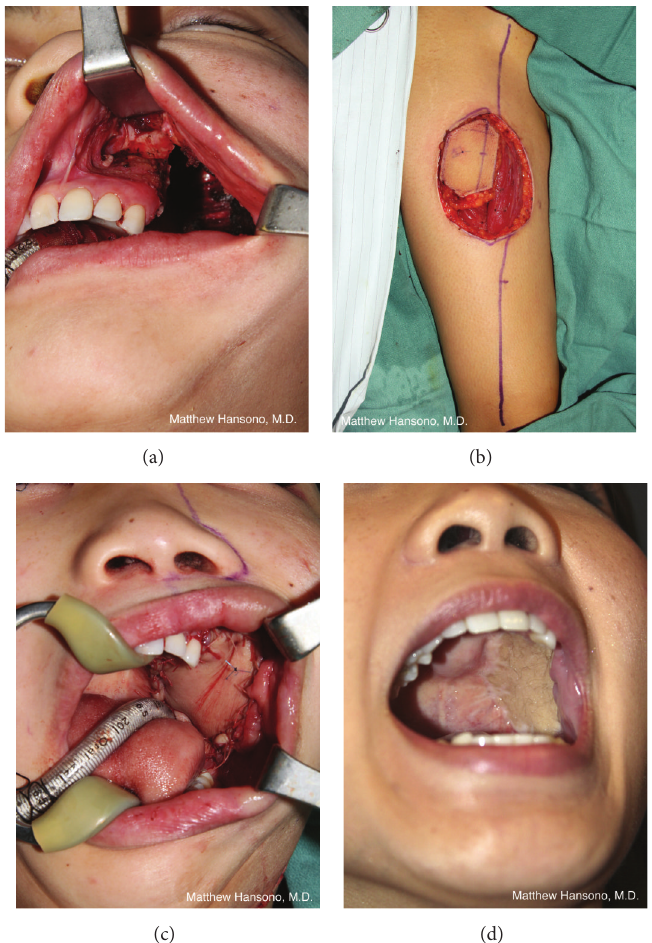
Figure1:Posteriorpalatomaxillary defect following tumorremoval (a). Ananterolateral thighfreeflap isharvested, measuringapproximately 5 × 5 cm (b). Flap inset (c). Postoperative appearance